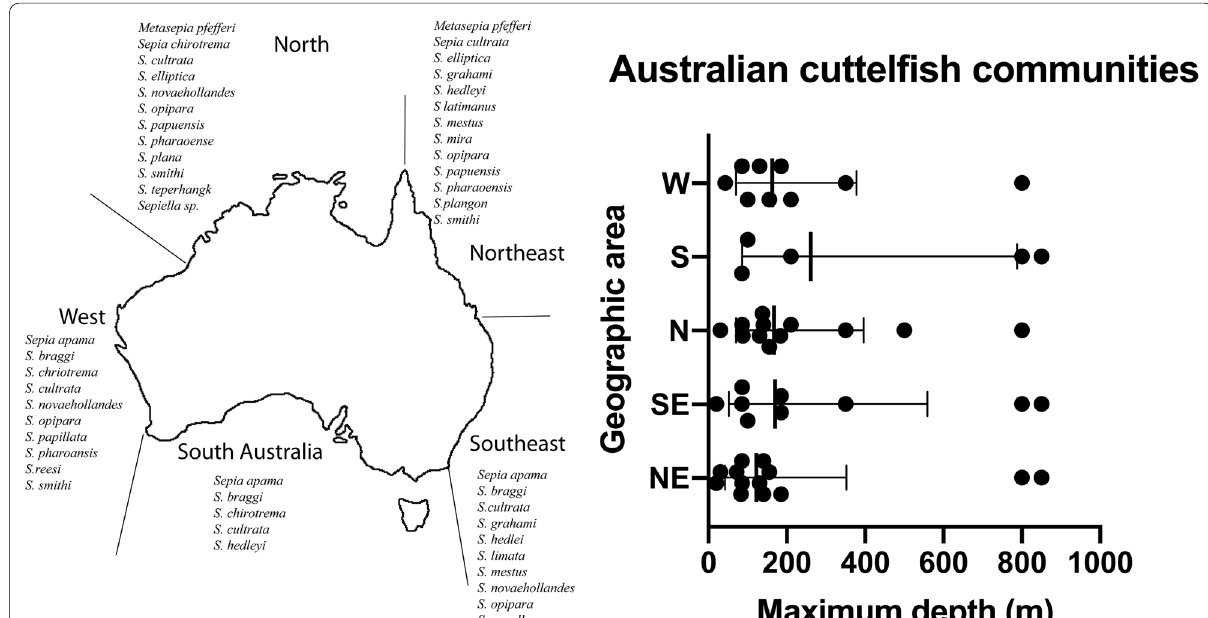
Fig. 14 A Map of Australia, showing sepiid species known from drift cuttlebones on beaches of region. From Reid (2016). B Maximum depths of species found in each region. These relatively diverse assemblages can be seen to be depth